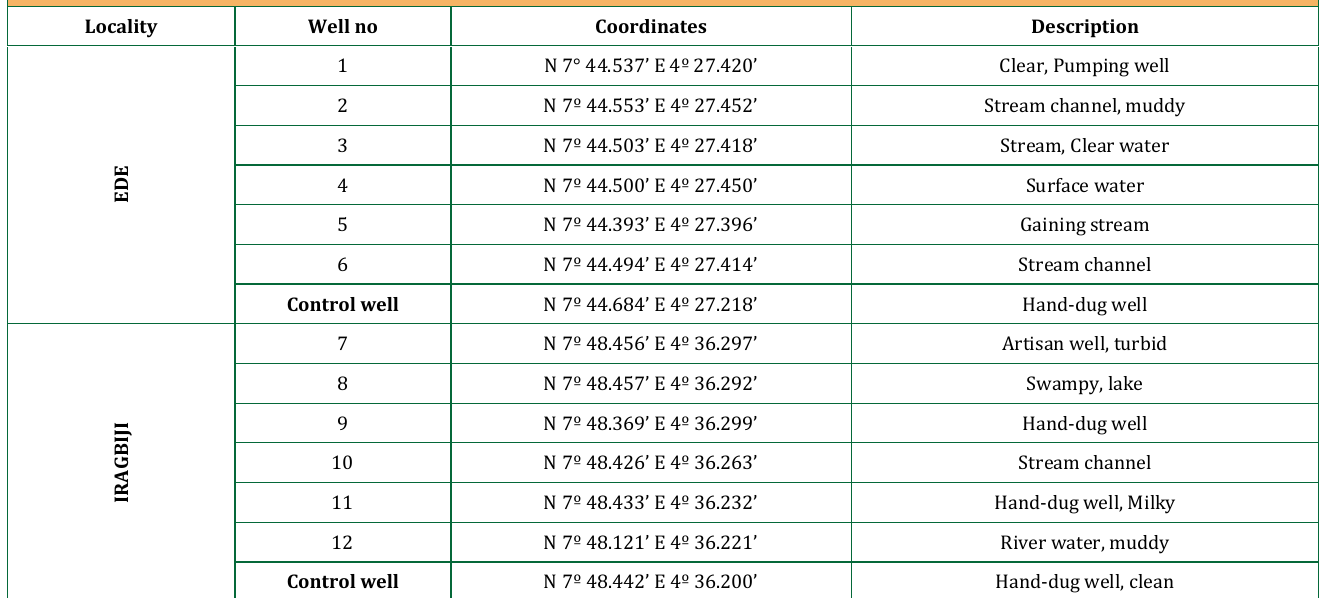
Water samples collected around the cemetery at Ede.